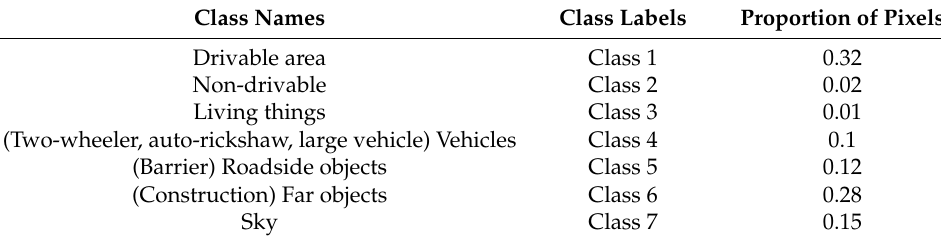
Table 1. IDD-Lite dataset class labels with class names and the proportion of pixels in each class.